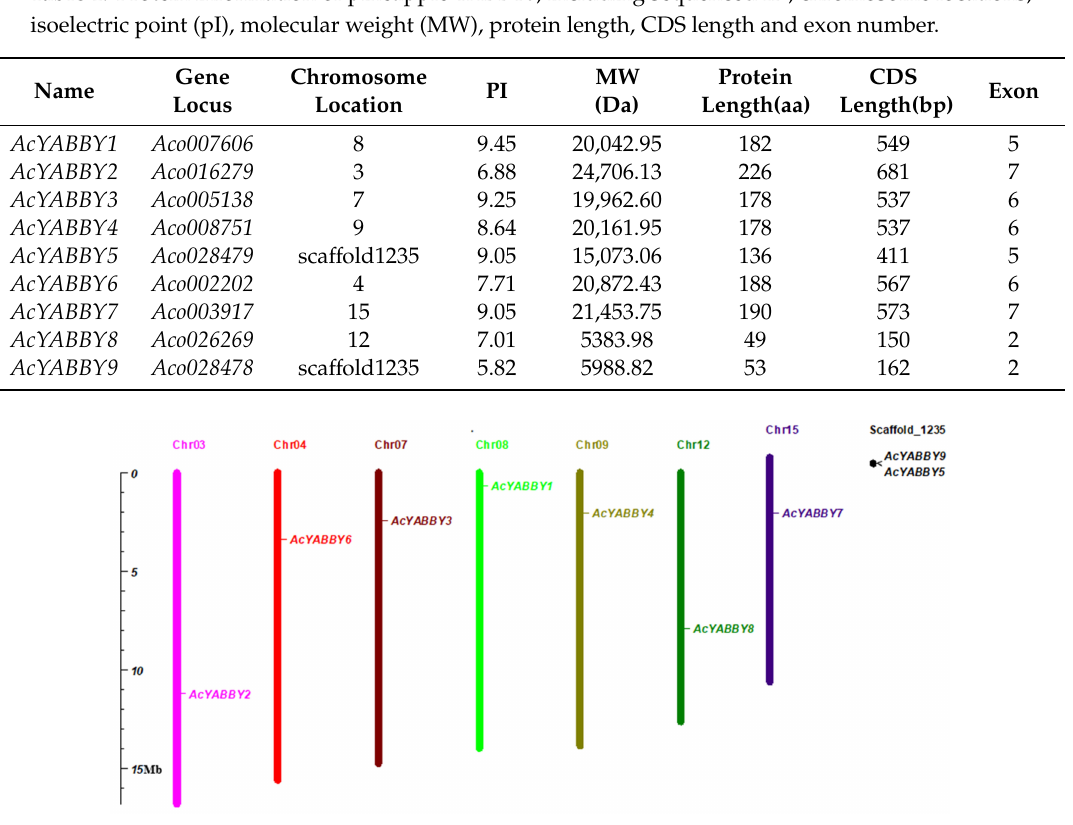
Table 1. Protein information of pineapple YABBYs , including sequenced ID, chromosome locations,